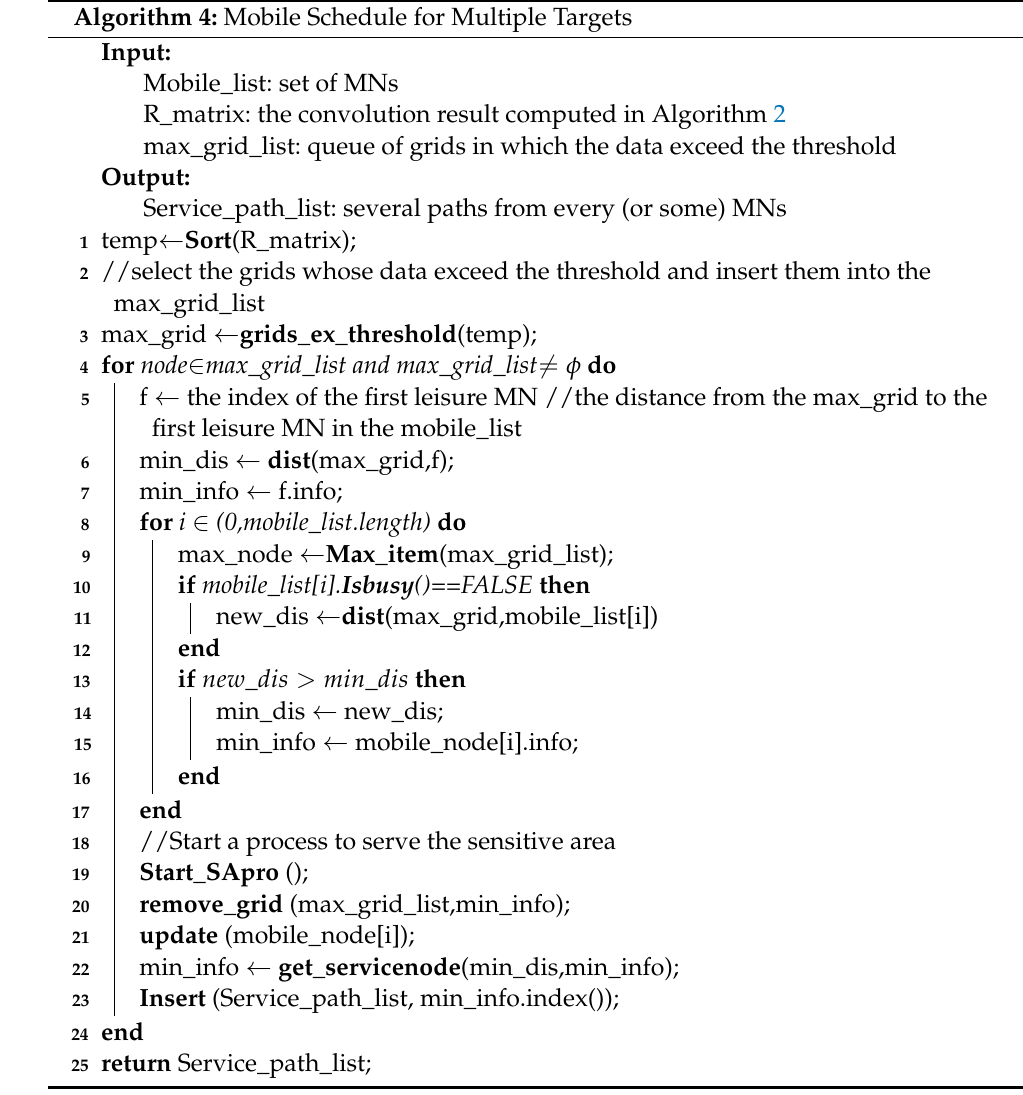
Algorithm 4: Mobile Schedule for Multiple